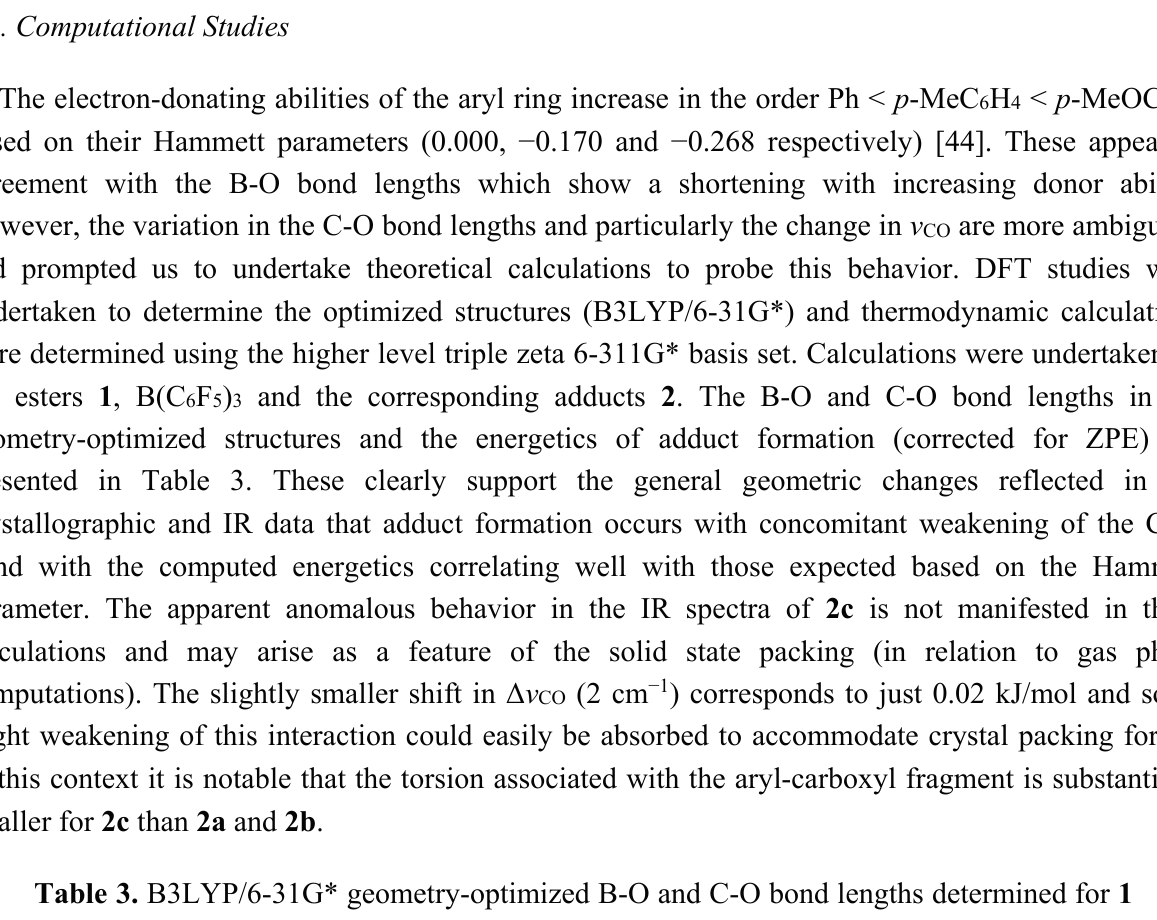
Table 3. B3LYP/6-31G* geometry-optimized B-O and C-O bond lengths determined for